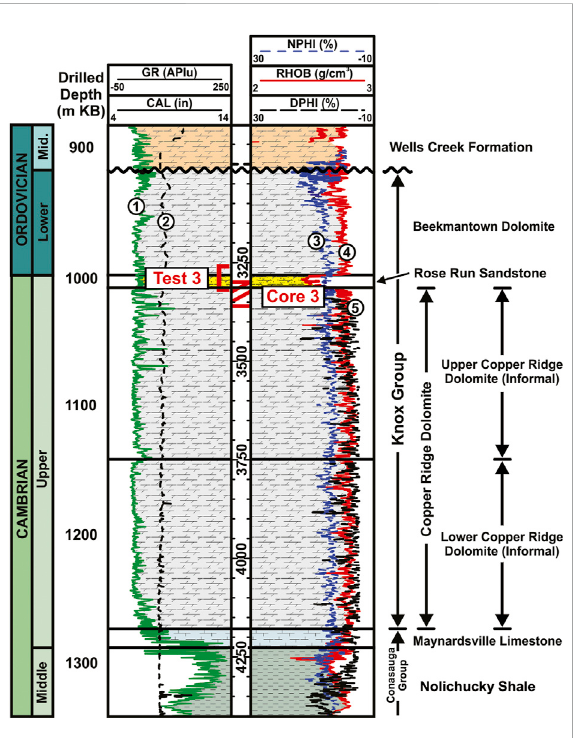
FIGURE 2 Correlated nuclear logs and lithostratigraphy of the Knox Group and deeper strata in the KGS 1 Hanson Aggregates well. Cored intervals are shown in the depth track and test intervals are posted. Log curves shown are the gamma-ray (curve 1, left track), wellborecaliper (curve2, lefttrack), neutronporosity(curve 3, right track), formation density (curve 4, right track), and density porosity (curve 5 right track). Modi fi ed from Bowersox et al.